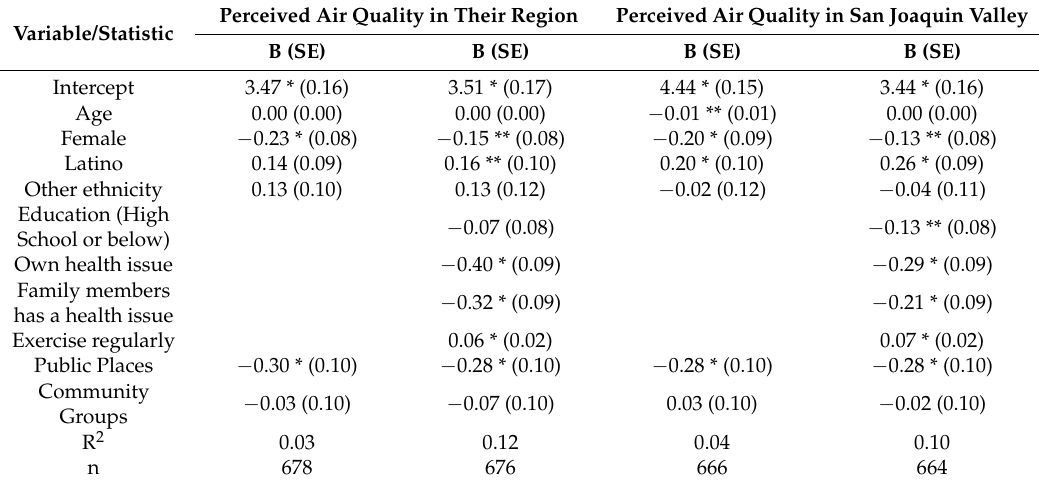
Table 3. Predictors of perceived air quality in their region and in the San Joaquin